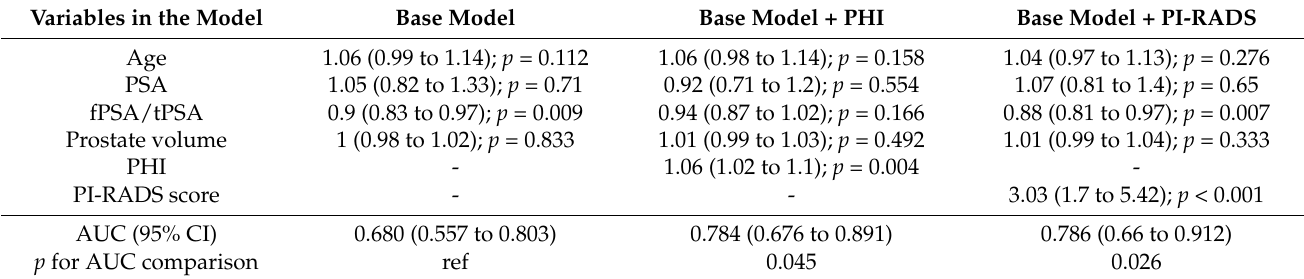
Table 4. Multivariable logistic regression models for the identification of csPCa at RP. Results of the models are expressed as odds ratios with the corresponding 95% confidence intervals.